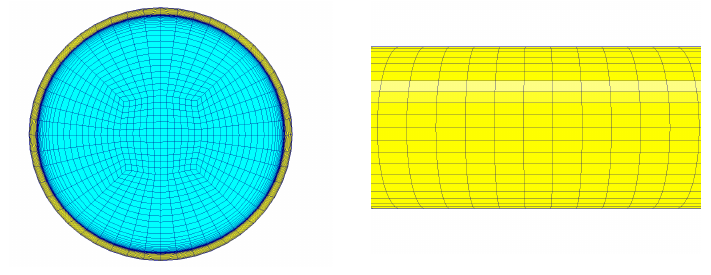
Figure 2. All grids were very fine in the near-wall region in order to resolve the viscous sub-layer as + ≈ the Y 1 is considered in the near-wall node. Energies 2020 , 13 , x FOR PEER REVIEW